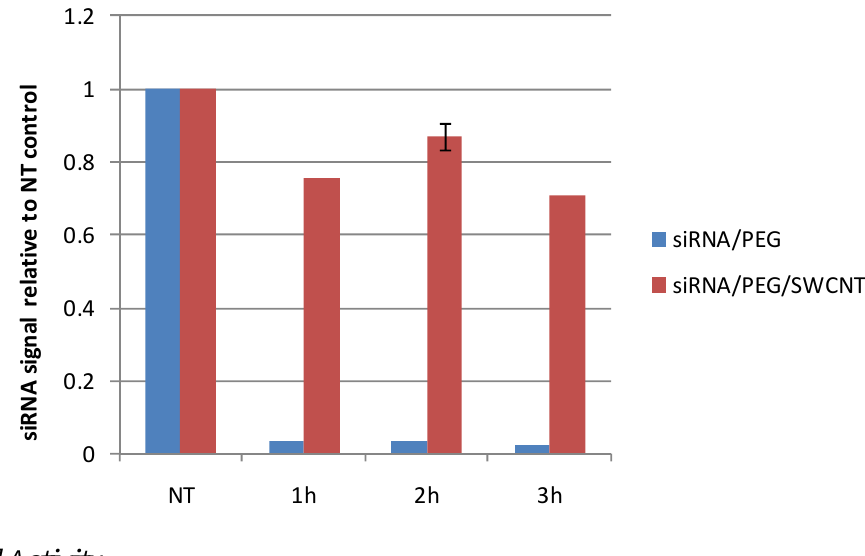
Figure 6. siRNA remaining after exposure to ribonuclease (10 units RNAseONE TM Ribonuclease) at 37 °C for 1, 2 and 3 h in solutions of free siRNA in 64 µM PEG or siRNA complexed to SWCNT with 64 µM PEG. No treatment (NT) controls were incubated at 37 °C for 3 h. Resulting solutions were separated on agarose gels and the siRNA quantified using CareStream In Vivo MS FX PRO